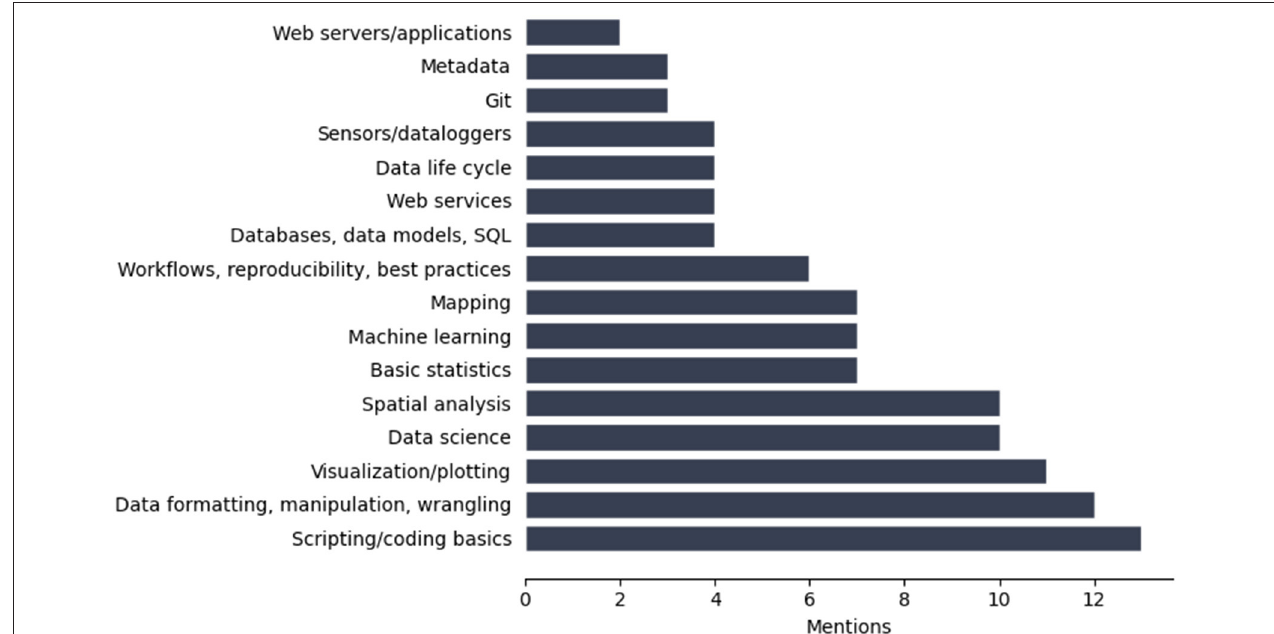
FIGURE 1 | Count of mentions related to subjects taught by